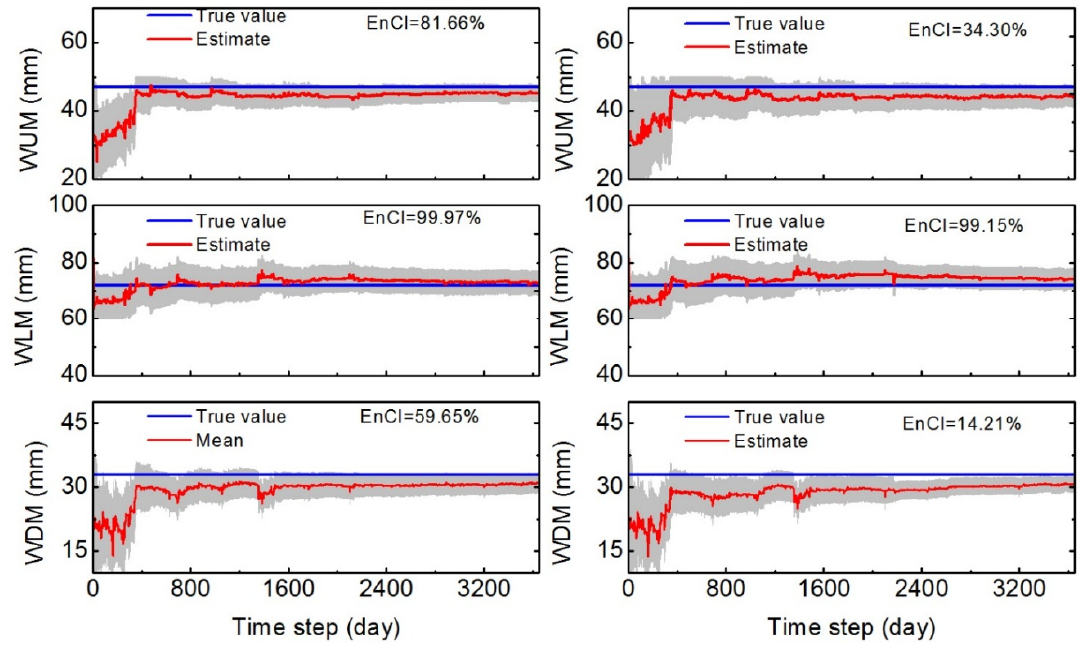
Figure 3. Estimations for WUM , WLM and WDM for two non-stationary cases: the gradual ( left ) and the rotational ( right ) changes. The results for the sudden change are not shown. Please note the three parameters do not temporally change since they are more stable than B and SM .